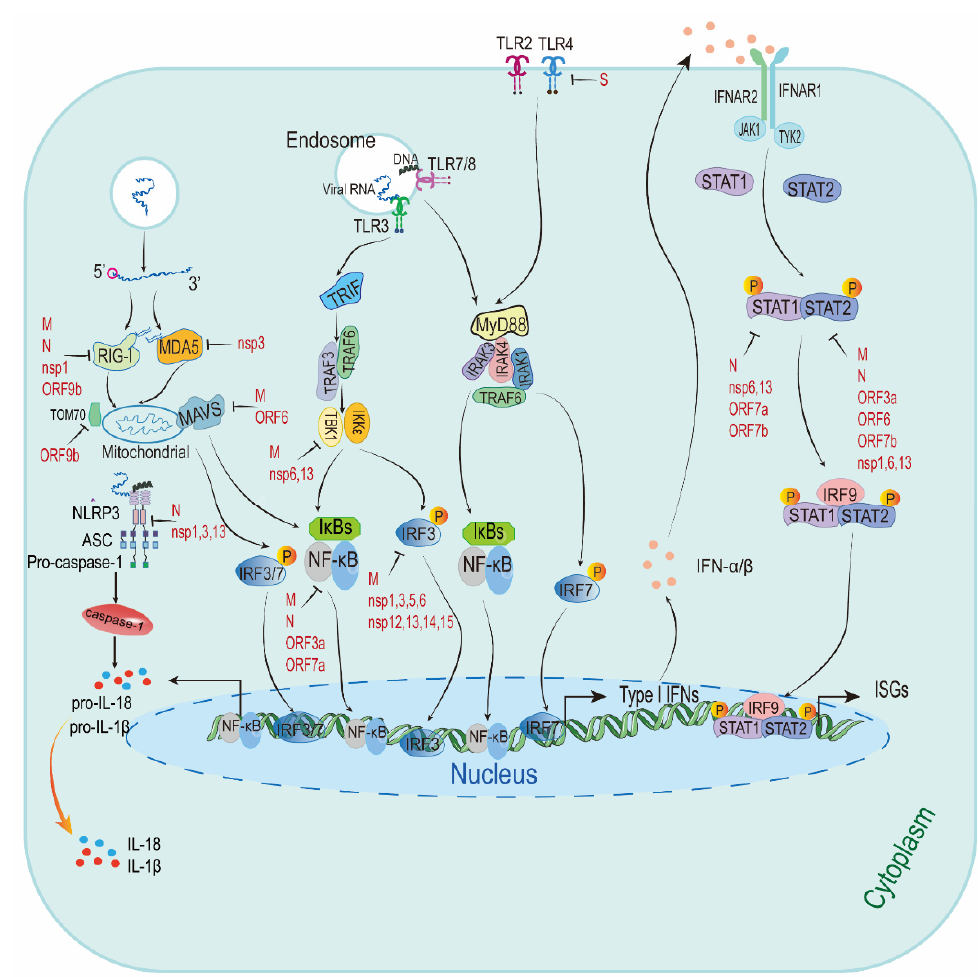
Figure 2. The predictive model describing the innate immune responses to SARS-CoV-2. There is a simplified figure of the type I IFNs responses after sensing SARS-CoV-2. It has been suggested SARS-CoV-2 escape type I IFNs signaling pathway and ISGs by targeting type I IFNs signaling. Viral proteins with type I IFNs inhibitory activities are highlighted in red. RIG-I: retinoic-acid inducible gene I; MDA5: melanoma differentiation-associated gene 5; MAVS: mitochondrial antiviral signaling protein; nsp1: non-structural protein; TOM70: translocases of outer membrane 70; NLRP3: NLR family pyrin domain-containing 3; ASC: apoptosis-associated speck-like protein containing a CARD; pro-IL-18: pro-interleukin (IL)-18; TLR3: Toll-like receptors 3; TRIF: TIR domain-containing adaptor inducing interferon- β ; TRAF3: tumour necrosis factor receptor-associated factor 3; TBK1: TANK-binding kinase 1; IKK ε : inhibitor of κ -B kinase ε ; I κ Bs: inhibitor κ B; NF- κ B: nuclear factor κ B; IRF3: IFN regulatory factor 3; MyD88: myeloid differentiation primary response 88; IRAK3: interleukin-1-receptor-associated kinase 3; IFNAR1: IFN receptor type I; JAK1: Janus-activated kinase 1; TYK2: tyrosine kinase 2; STAT1: signal transducer and activator of transcription 1; ISGs: interferon-stimulated genes.